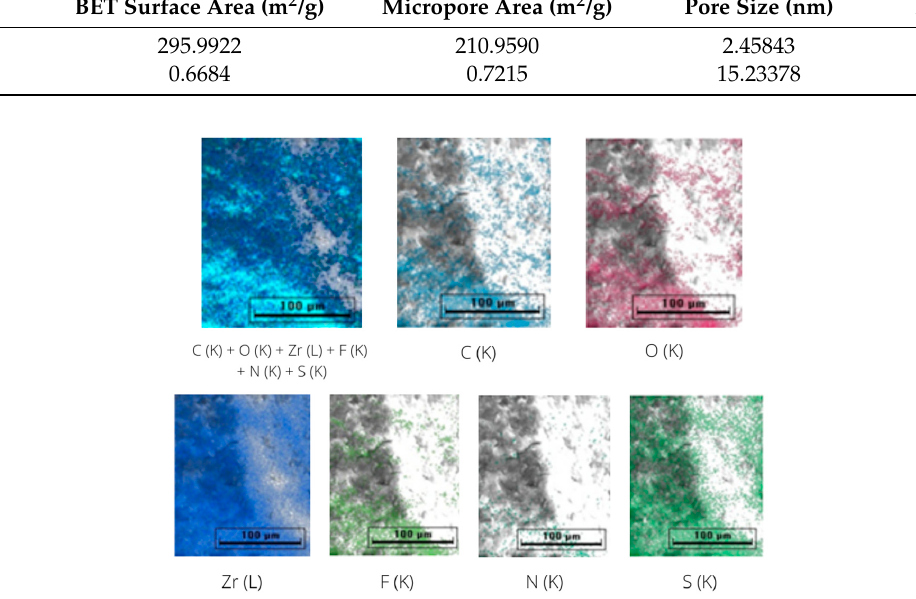
0.000373 Figure 8. Nitrogen adsorption–desorption isotherms curves for UiO − 66.